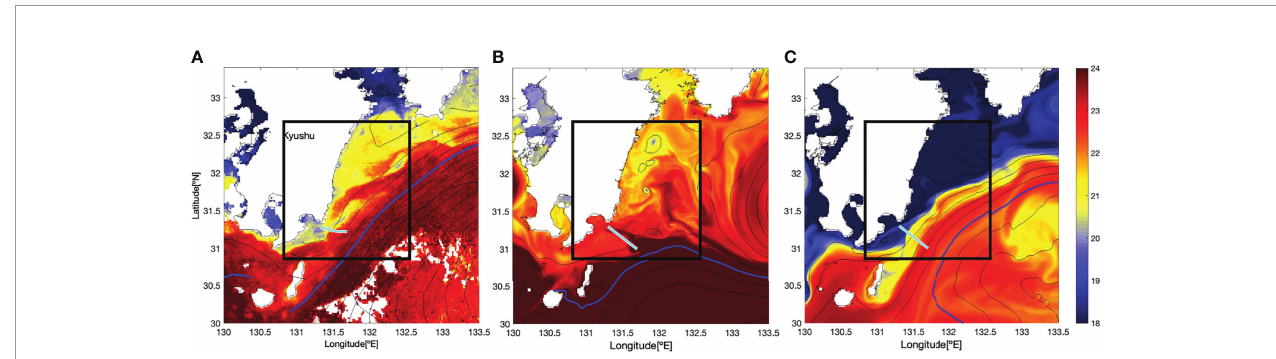
FIGURE 1 | Sea Surface Temperature °C for (A) satellite observation by Himawari-8 on Nov25 th , 2018, and for the ROMS simulation on (B) November 11 th and (C) December 20 th . Thin black contours represent Sea Surface Height (SSH), and the Kuroshio axis is represented as the blue contour at SSH = 1.1 m for (A) the observation (COPERNICUS Marine Service) and at SSH = 0.2 m for (B, C) the simulations. Cyan lines represent where the vertical sections are computed, and black squares enclose the fi nest grid region of